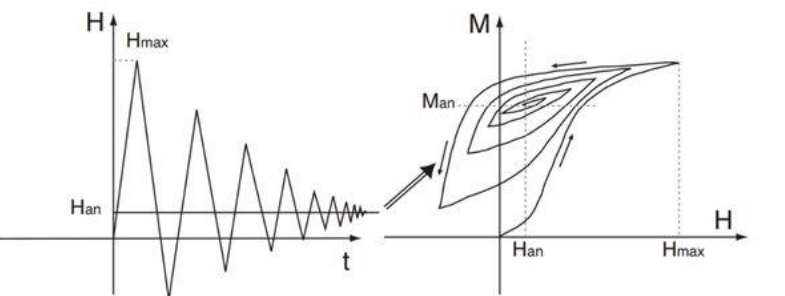
Figure 5. The “classical” method to recover a single point on the anhysteretic curve by the application of decaying alternating field at a given bias level; this procedure has to be repeated many times, and it is thus tedious and time-consuming.